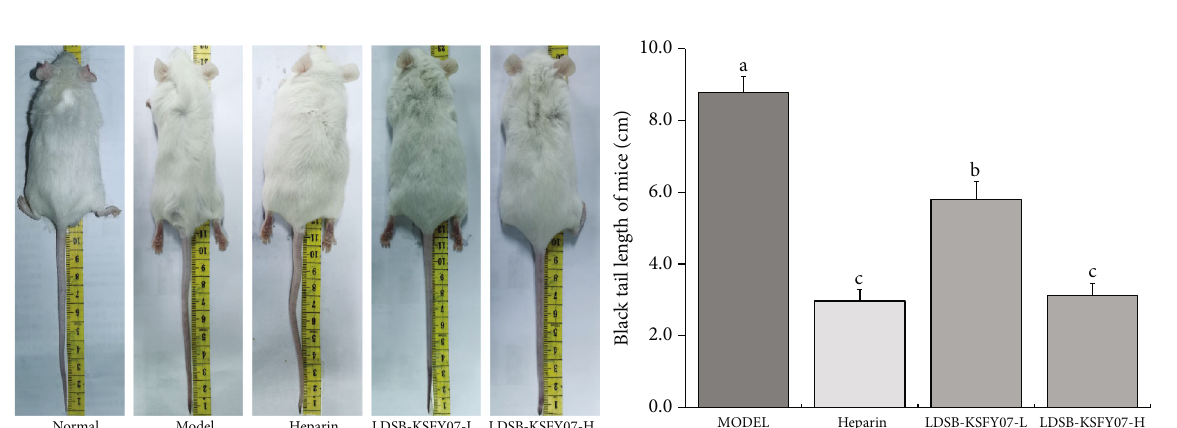
Figure 1: Tail thrombus of mice in each group. The results have been expressed as mean ± deviation . (A – D) Mean values with di ff erent bars in the di ff erent column are signi fi cantly di ff erent ( P < 0 : 05 ) according to Duncan ’ s multiple range test. Table 2: The activated partial thromboplastin time (APTT), thrombin time (TT), fi brinogen (FIB), and prothrombin time (PT) of mice with kappa-carrageenan-induced thrombosis.